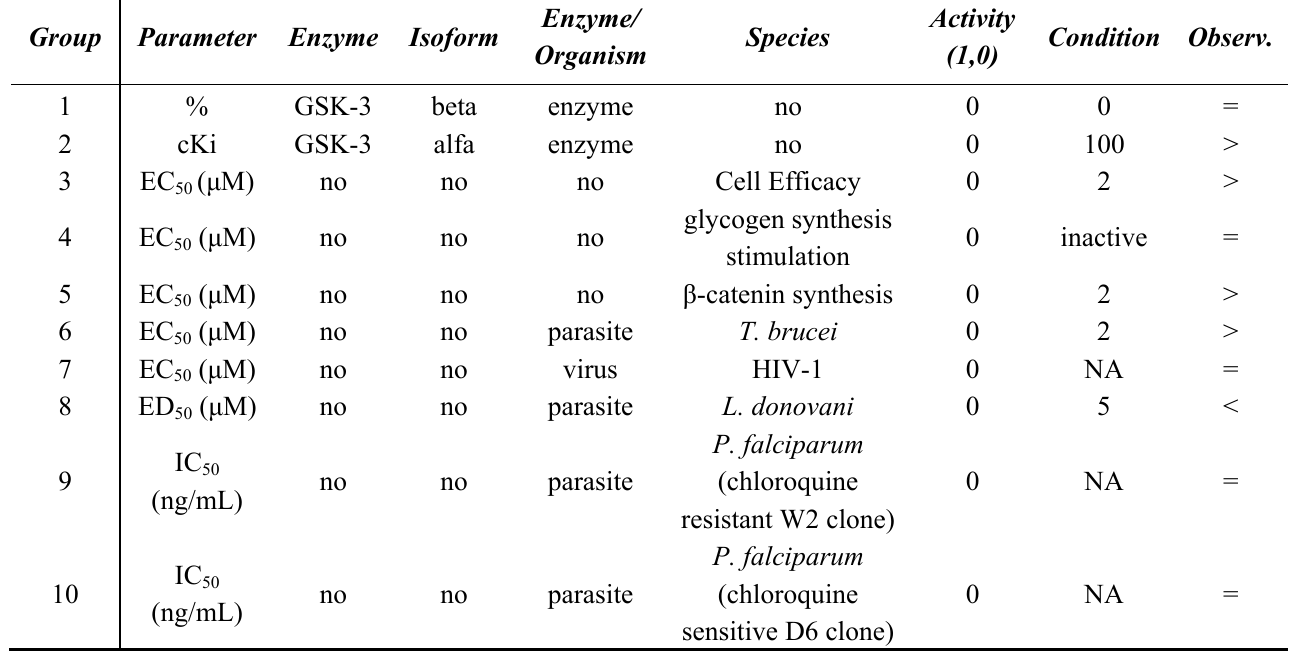
Table 3. Compound Assay Conditions query